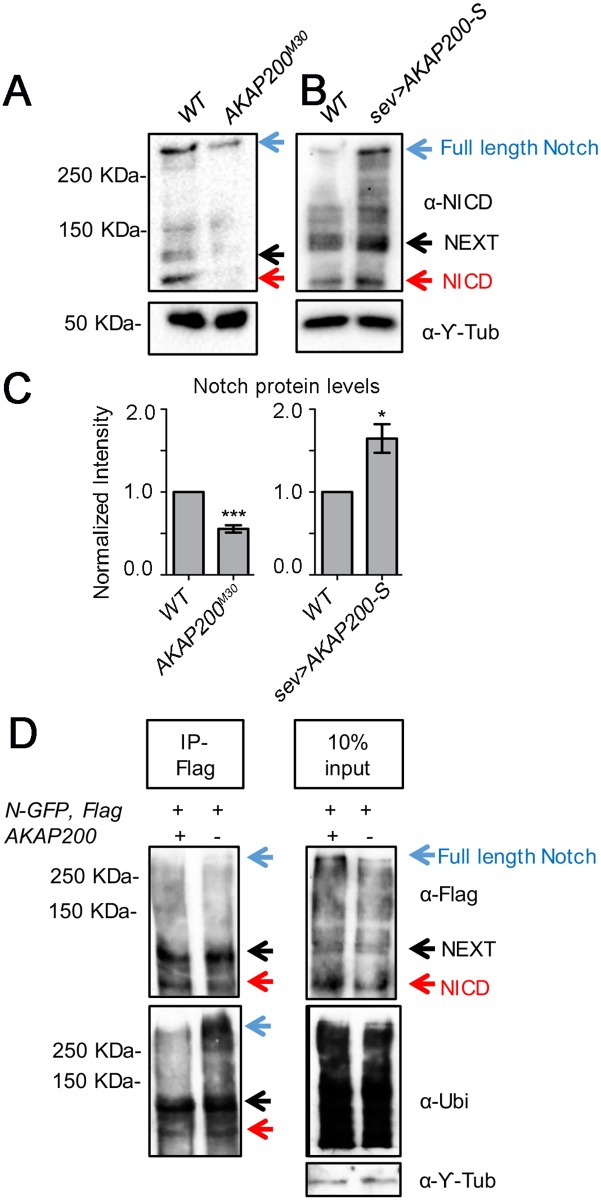
AKAP200 affects Notch levels and ubiquitination.(A-B) Western blots of third instar larval eye disc extracts using NICD and gamma tubulin antibodies [blue arrow: full length Notch; black arrow: membrane bound NEXT; red arrow: NICD, [100]]. (A) In AKAP200M30 samples, note a decrease in Notch protein levels compared to WT (loading control:©-Tubulin [Y-Tub], bottom here and all other panels). (B) Over-expression of AKAP200-S (by sev-Gal4) leads to an increase in Notch levels, compared to WT. (C) Quantification of Notch protein levels in (A-B) (n = 3, ***p<0.0001, *p = 0.01 by student’s t test; error bar = standard deviation). (D) Increased ubiquitination of Notch is observed in AKAP200M30 mutant. Eye disc lysates from Notch-Flag/+ or Notch-Flag/+, AKAP200M30/+ were immunoprecipitated with anti-Flag and probed with anti-Flag and anti-Ubiquitin. Leupeptin and protease inhibitors were added to the lysis buffer. Blotting with anti-Ubiquitin revealed an increase of ubiquitinated full length Notch, NEXT and NICD in the AKAP200 mutant.